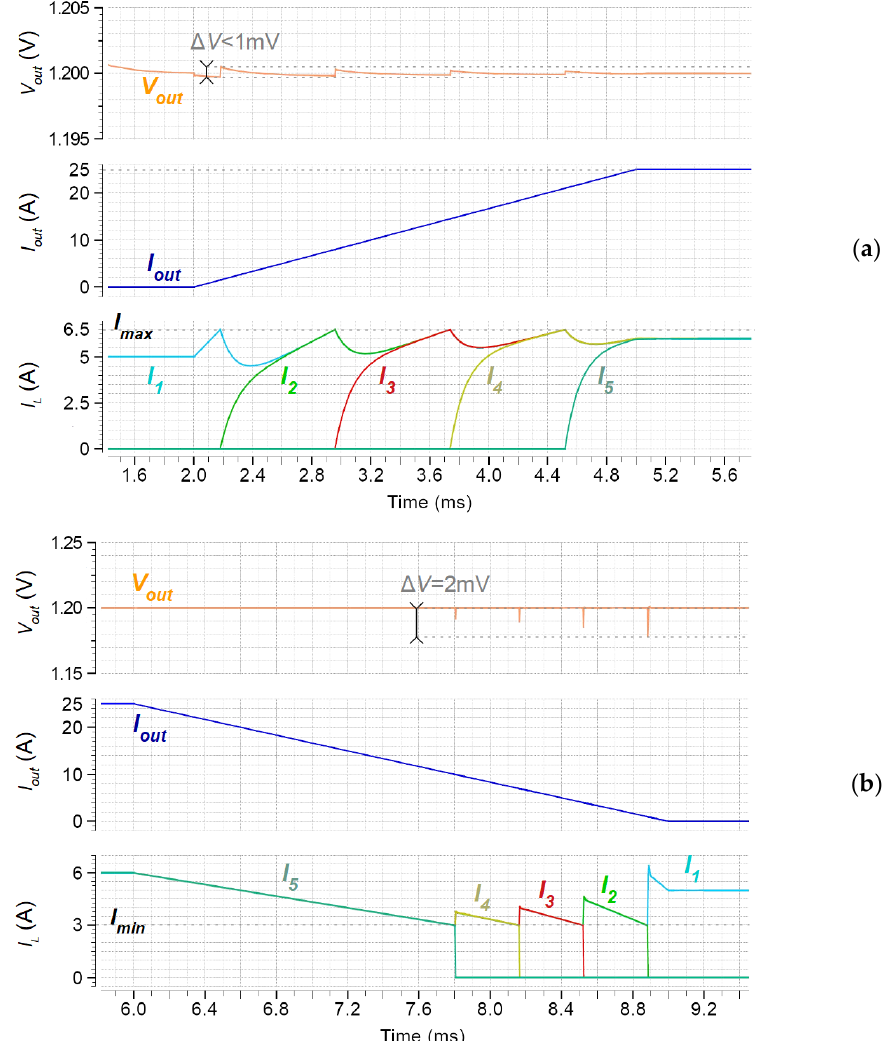
Figure 7. Simulation of the converter response for a slow load transient: ( a ) load current rising from 0 to 25 A with LC turn-on sequence ( I max = 6.5 A); ( b ) load current falling from 25 to 0 A with LC turn-off sequence ( I min = 3 A).